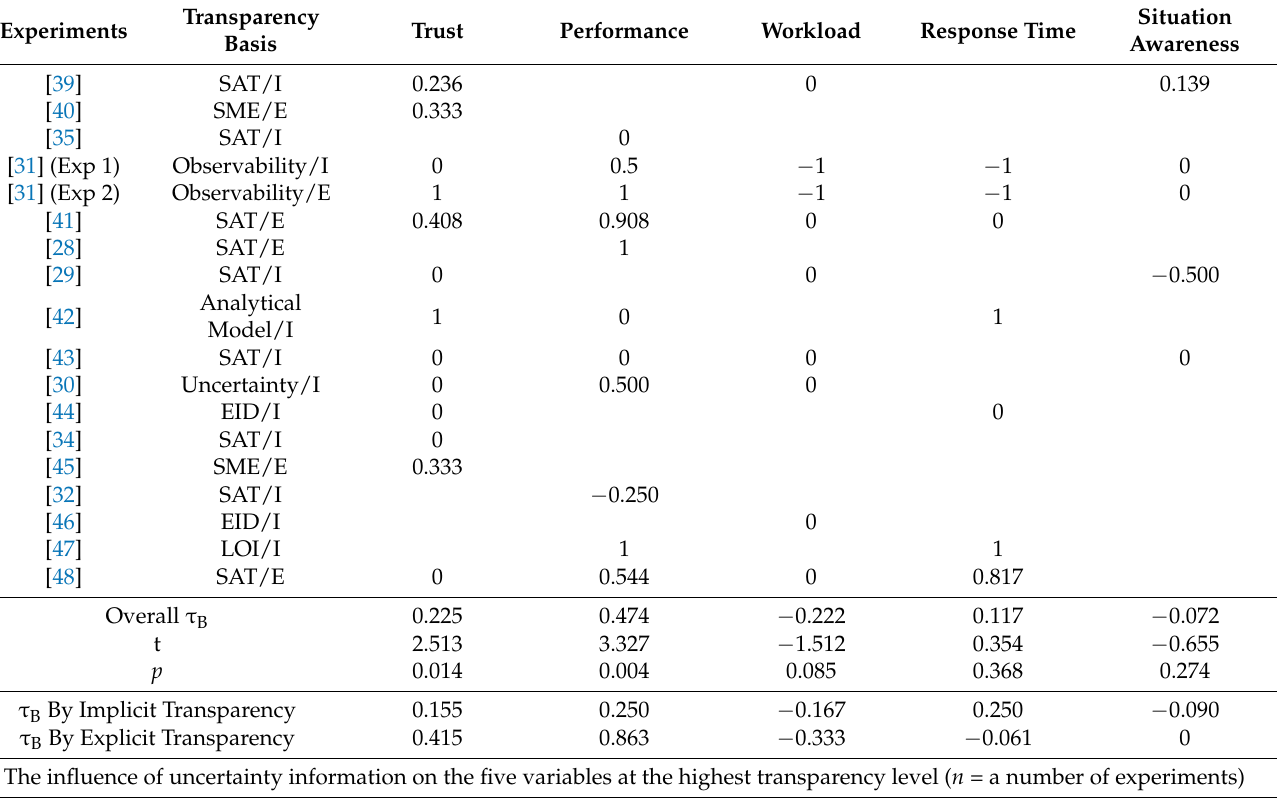
Table 6. The overall associations ( τ B coefficients) between key HF and transparency levels, and the statistics of one-tailed t tests, are represented. The overall associations under different information presentation conditions (implicit and explicit) denoted as I and E, are demonstrated. Lastly, a number of experiments that either reported positive or negative effects of uncertainty information on key HF is shown. For example, two experiments reported positive effects on trust. The positive effects indicate the increase in trust, performance, and situation awareness, and a decrease in workload and response